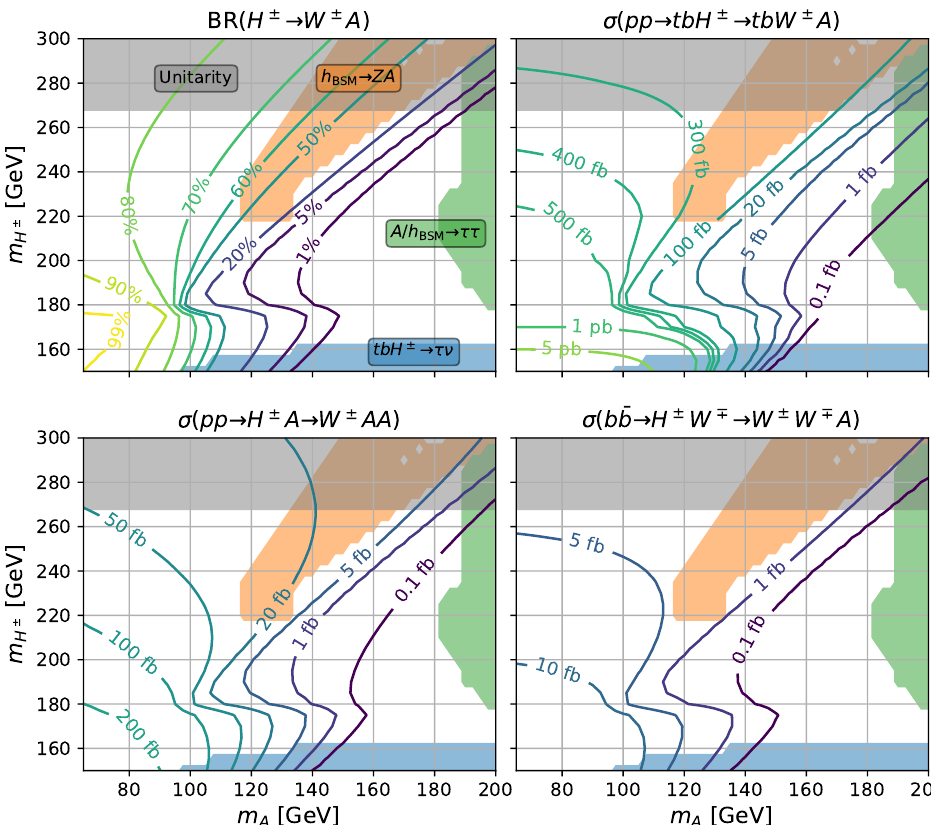
Figure 17. Benchmark scenario cH ( WA ) in the ( m , m A ) parameter plane. The colored contour H ± lines indicate BR ( H ± → W ± A ) in the top-left panel and the 13 TeV LHC signal cross sections in the pp → tbH ± → tbW ± A ( top-right ), pp → H ± A → W ± AA ( bottom-left ), and pp → W ± → H ∓ → W ± W ∓ A ( bottom-right ) channels in the remaining panels. The colored regions of parameter space are excluded by current constraints from searches in the pp → h [199–201], BSM → ZA pp → A/h BSM → τ + τ − [202] and pp → tbH ± , H ± → τ ± ν τ [183] channel. Theoretical constraints from perturbative unitarity ( gray region ) also impact cH ( WA )